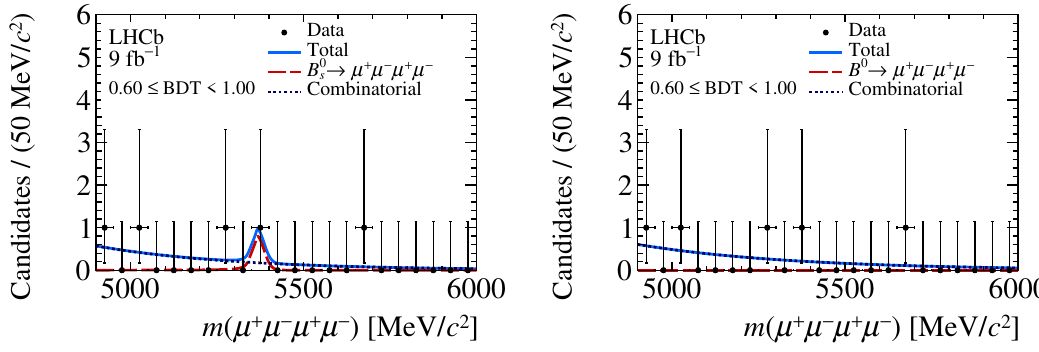
Figure 5 . Distribution of the µ + µ − µ + µ − invariant mass of candidates passing the B 0 → µ + µ − µ + µ − selection in the most sensitive BDT interval, with the fit models used to de- ( s ) termine the branching fractions of (left) B 0